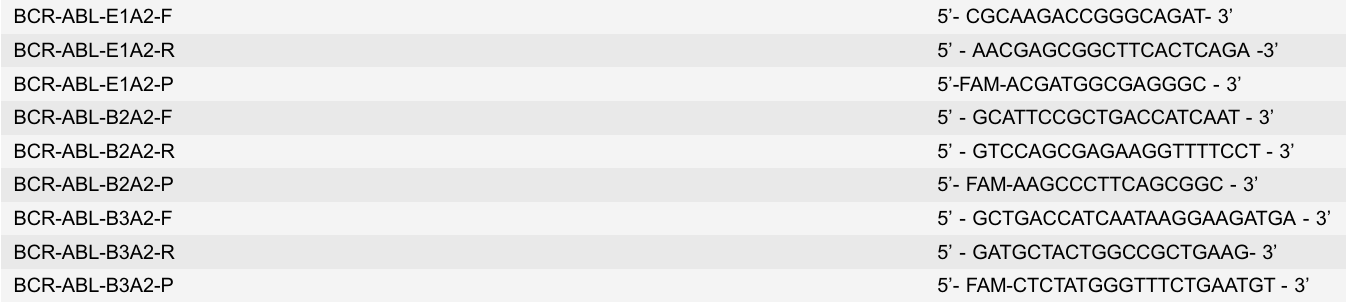
Table 1. PCR primers and probes